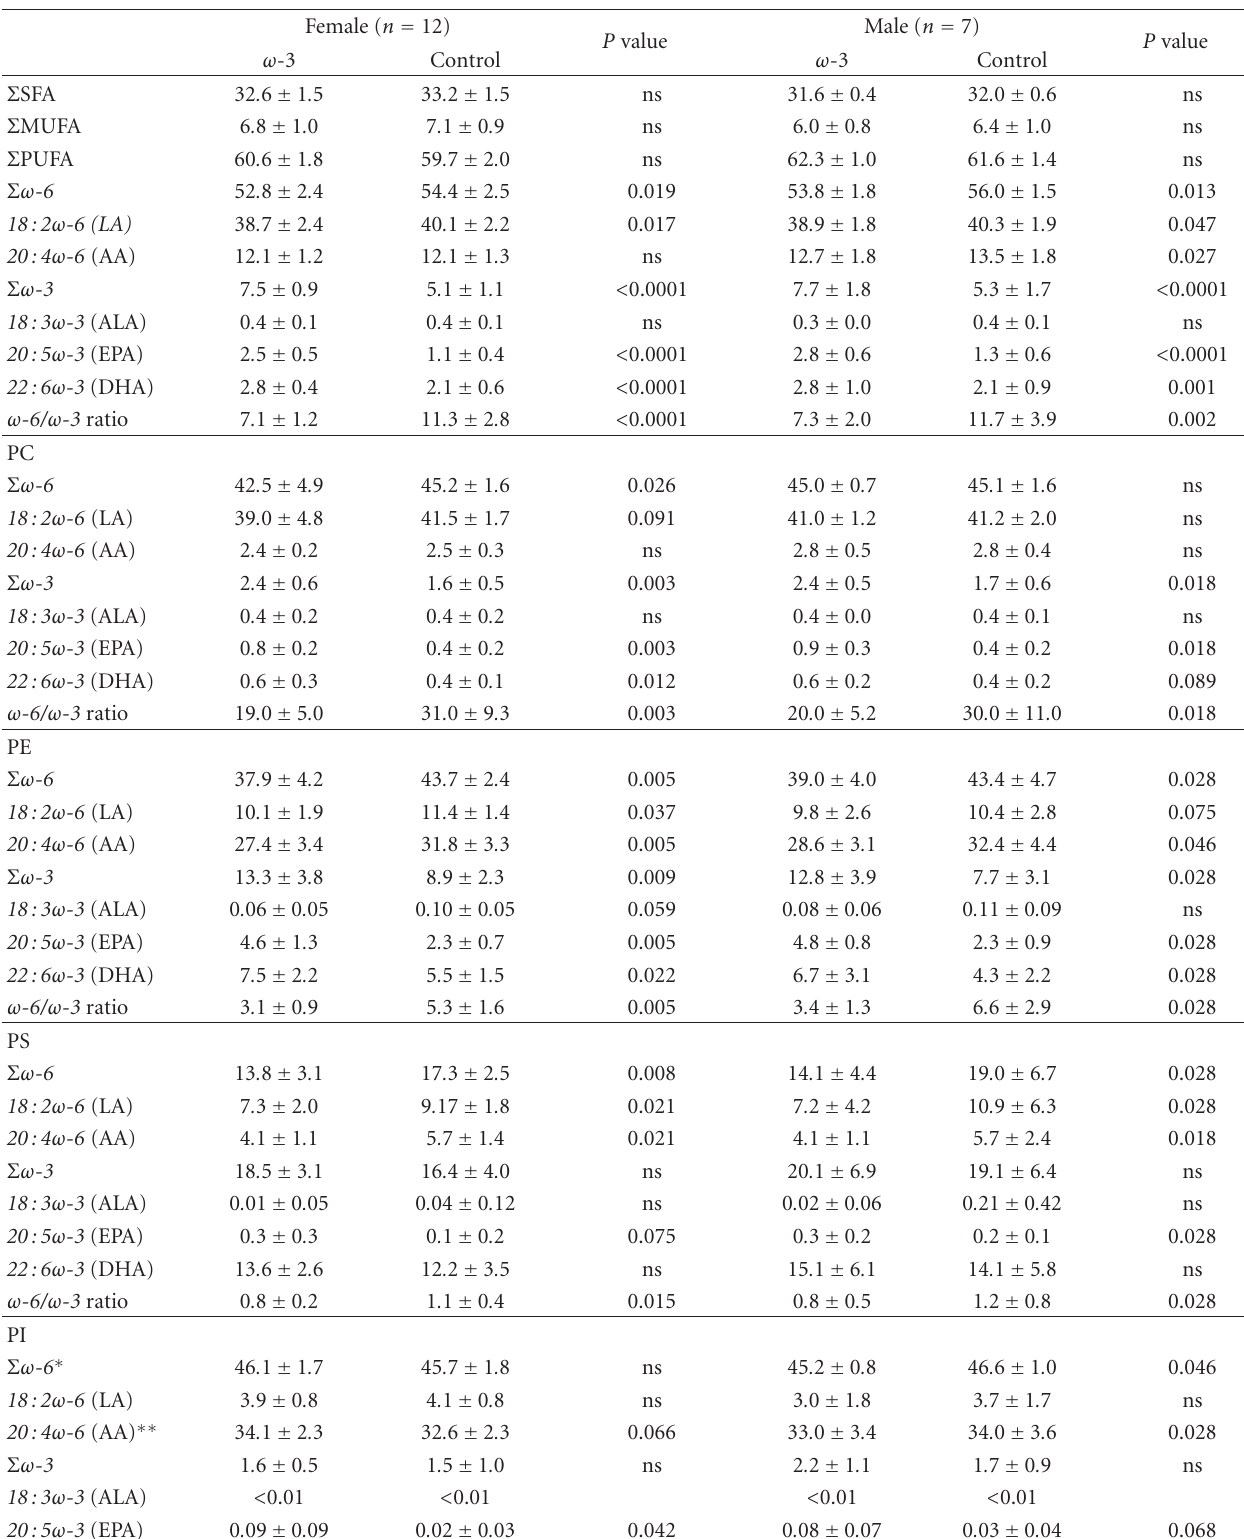
Table 2: Fatty acid compositions of total muscle phospholipids and of major glycerophospholipids, phosphatidylcholine (PC), phosphati- dylethanolamine (PE), phosphatidylserine (PS), phosphatidylinositol (PI), and cardiolipin (DPG) in 12 females and 7 males after 3-months treatment with omega-3 LCPUFAs or placebo, expressed as molar percentage of total